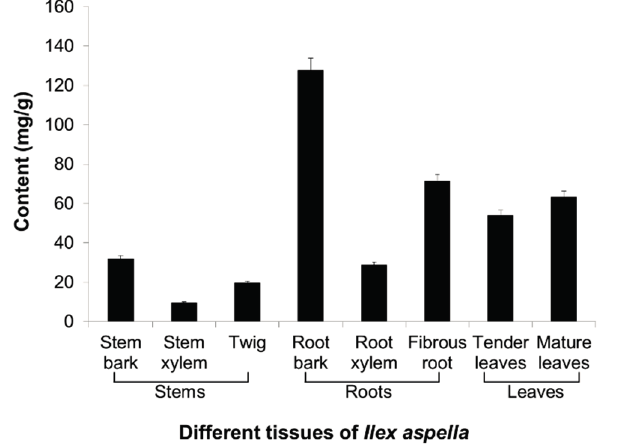
Figure 7. Localisation patterns of total saponin in different tissues of I. asprella. Absolute content of total saponins in different tissues were calculated according to a standard curve of a gradient concentration of ursolic acid solution. Error bars represent the standard errors of the means calculated from three technical